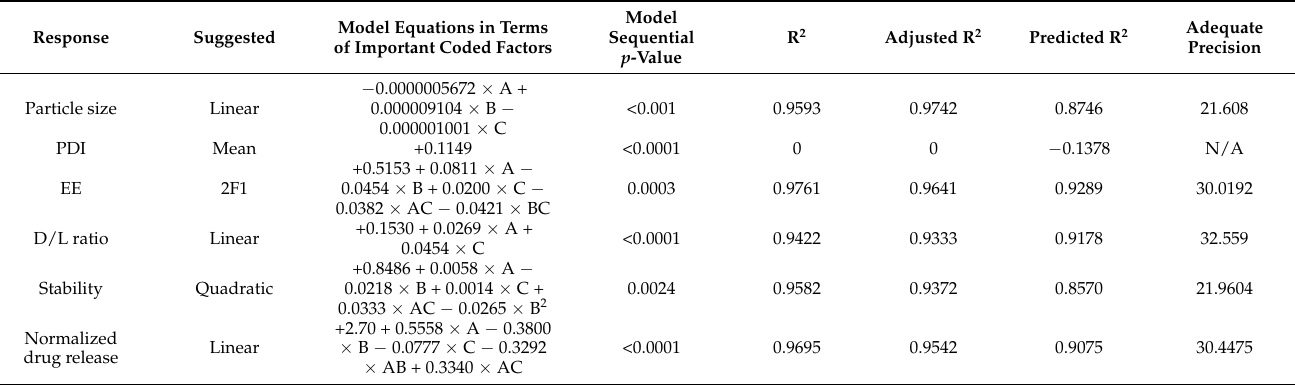
Table 3. Summary of regression analysis of